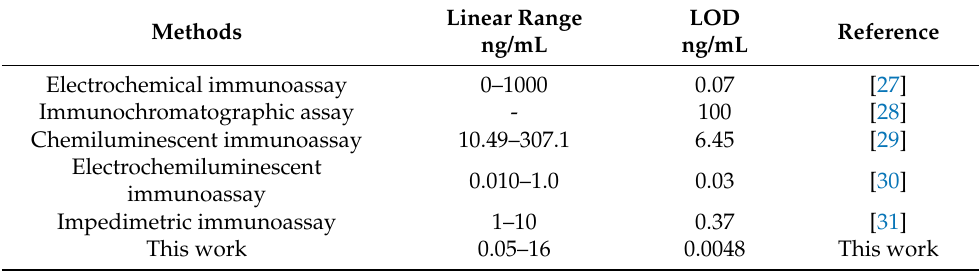
Figure 3. Calibration curve for detection of Cry1Ab at different concentrations. Table 1. Comparison of different immunoassays for Cry1Ab detection.